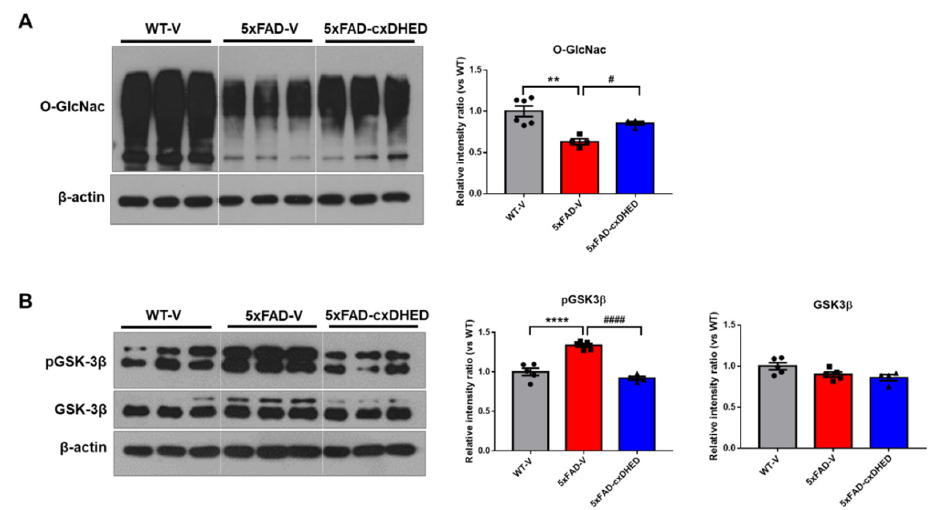
Figure 5. cx-DHED increased O-GlcNAcylation, but decreased phosphorylation of GSK-3 β in the brain of 5xFAD mice. ( A ) Representative blot and quantification of O-GlcNac expression in the cortex of the mice (WT-V; n = 6, 5xFAD; n = 4, 5xFAD-cx-DHED; n = 4). ( B ) The representative blot and quantification of the phosphorylation of GSK-3 β (pGSK-3 β ) and total GSK-3 β (WT-V; n = 5, 5xFAD; n = 5, 5xFAD-cx-DHED; n = 4). β -actin was used as a loading control. Values are expressed as the mean ± SEM. ** p < 0.01 and **** p < 0.0001 vs. WT-V group; # p < 0.05 and #### p < 0.001 vs. 5xFAD-V group. Statistical analysis between the three groups was performed using the one-way analysis of variance, followed by Turkey’s post hoc test.